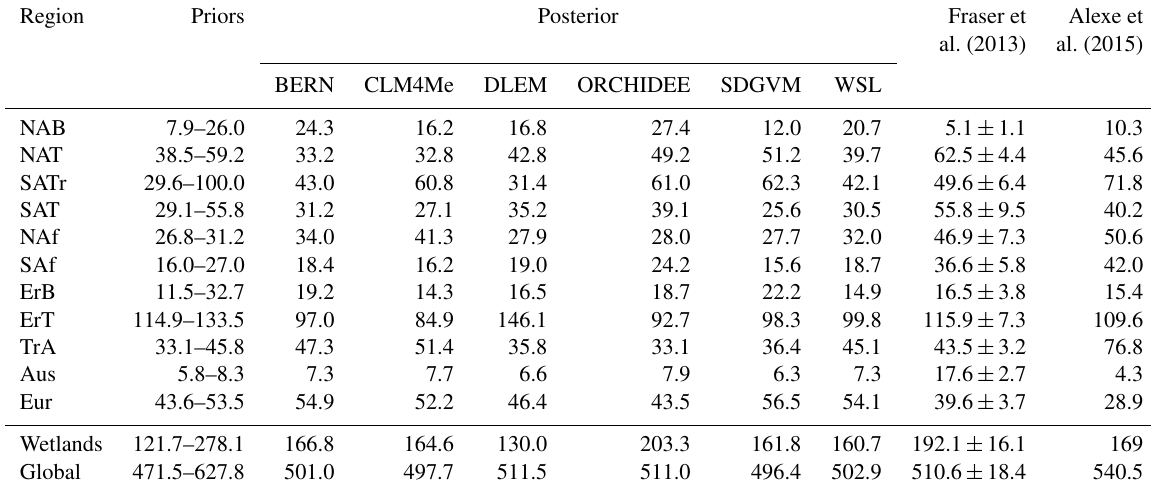
Table 2. Estimated annual CH 4 emissions (units: Tg CH 4 yr − 1 ) for TransCom 3 land regions (NAB: North American boreal; NAT: North American temperate; SATr: South American tropical; SAT: South American temperate; NAf: northern Africa; SAf: southern Africa; ErB: Eurasian boreal; ErT: Eurasian temperate; TrA: tropical Asia; Aus: Australasia; and Eur: Europe). The priors are the range of the initial CH 4 emissions given by the six scenarios. Region Priors Fraser